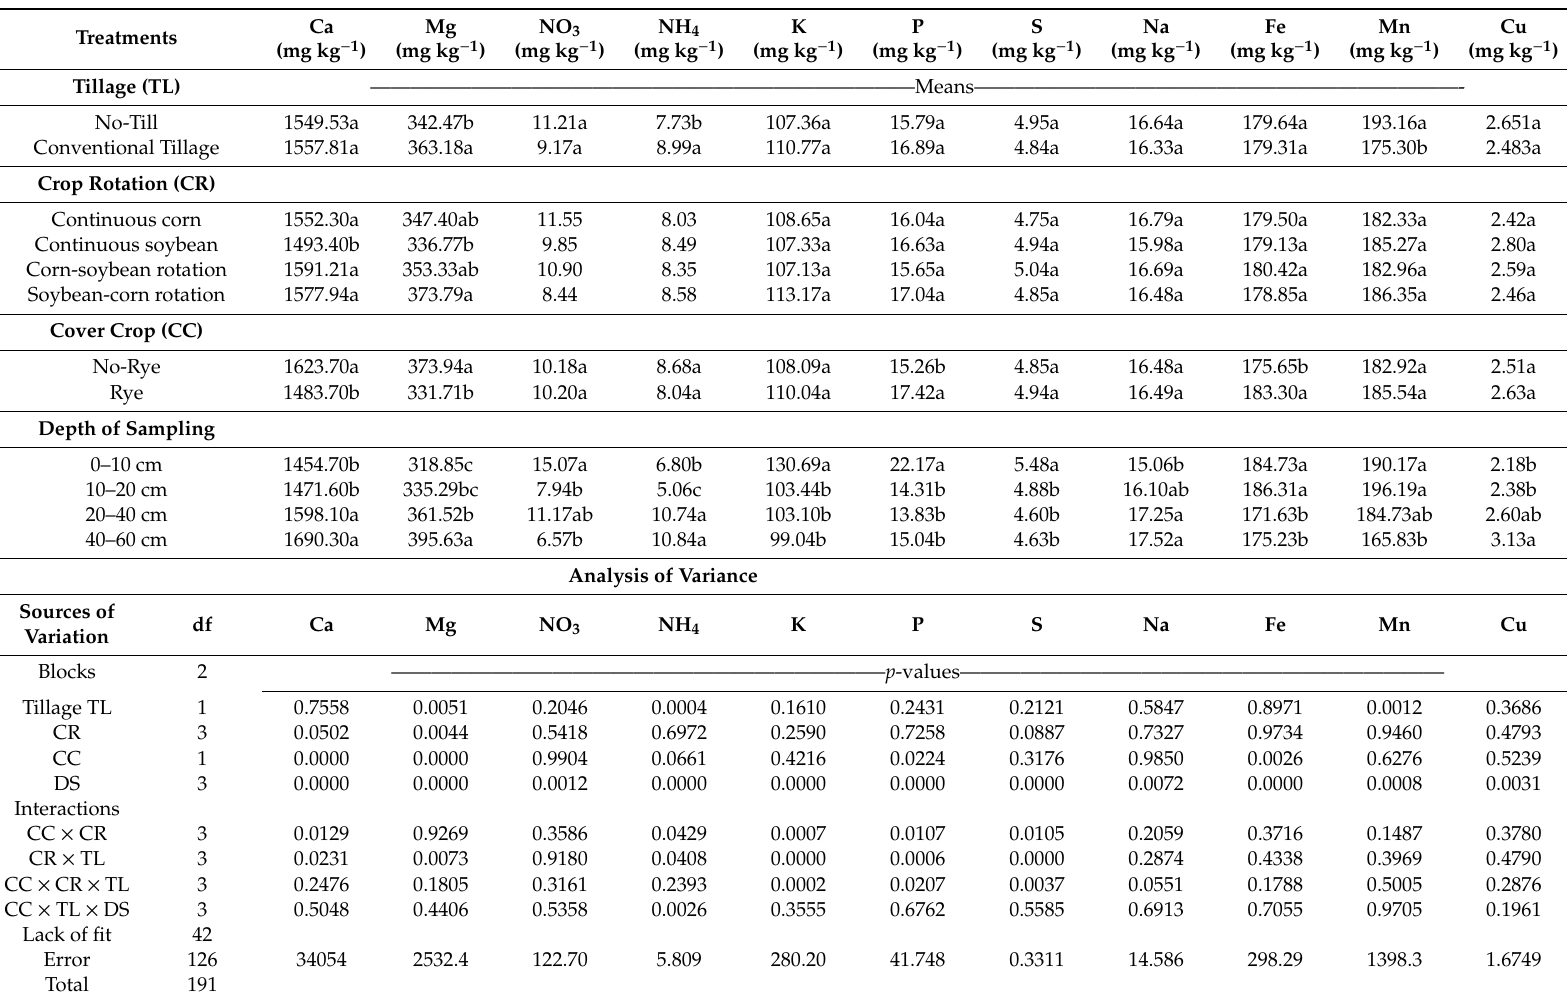
Table 4. E ff ects of tillage, crop rotation, cover crop and depth of sampling on selected soil nutrients in